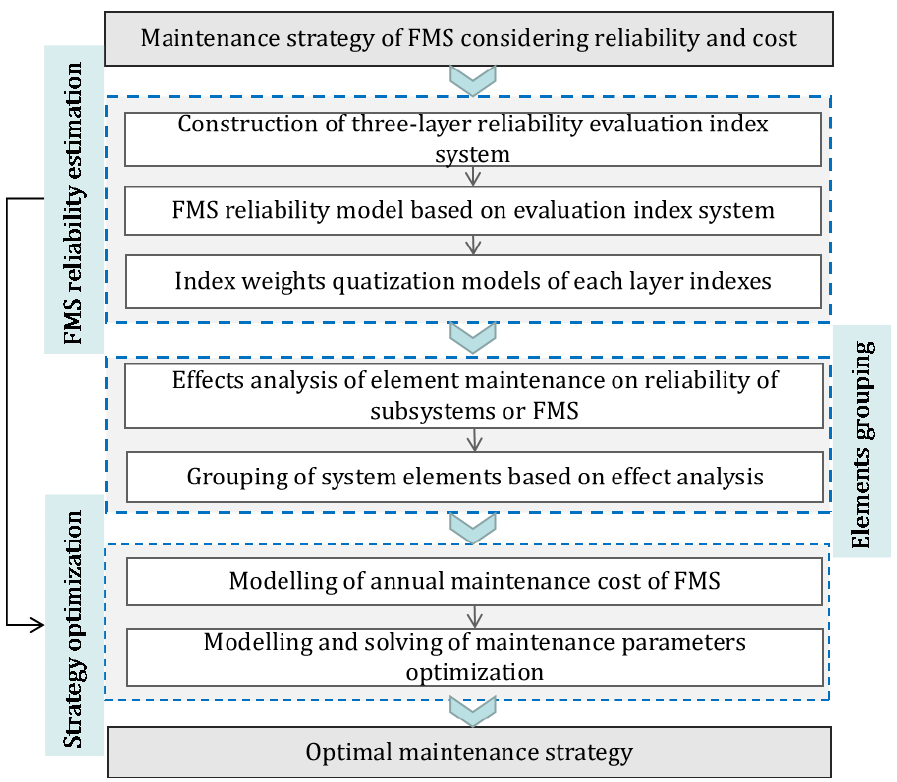
Figure 1. Whole framework of the proposed maintenance